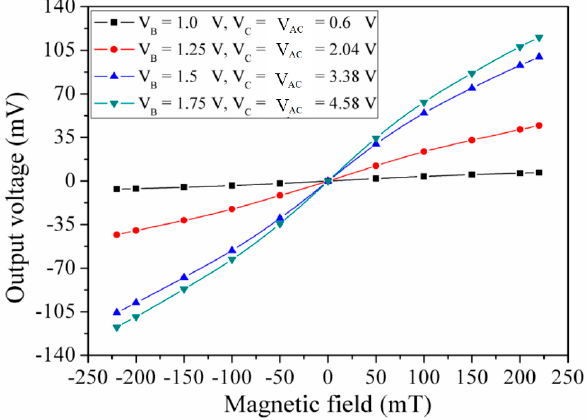
Figure 9. Measured output voltage in the y ‐ direction MF.